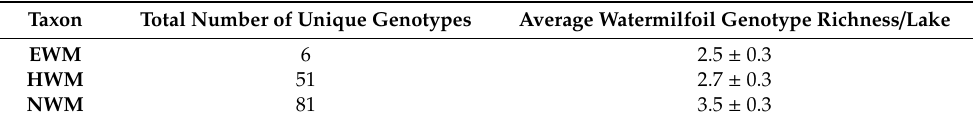
Table 2. Number of genotypes found for each taxon from assessed watermilfoil samples.